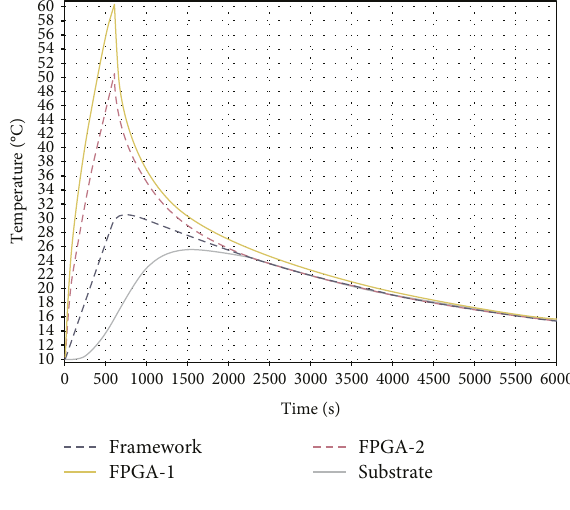
Figure 11: Characteristic temperatures.